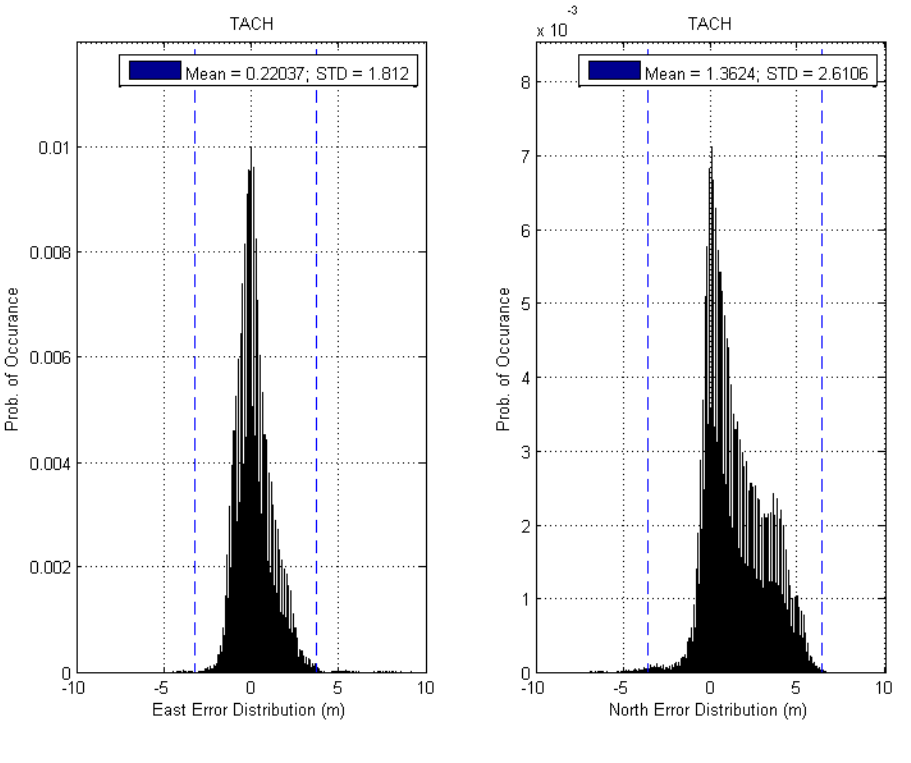
Figure 21. (a) The positioning error distribution and 95% error bound in east direction in Taipei FIR (3 RSs). (b) The positioning error distribution and 95% error bound in north direction in Taipei FIR (3 RSs).